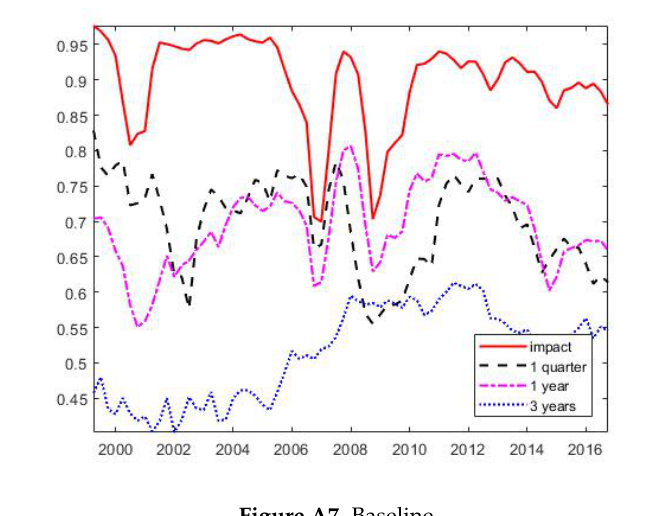
Figure A7. Baseline.